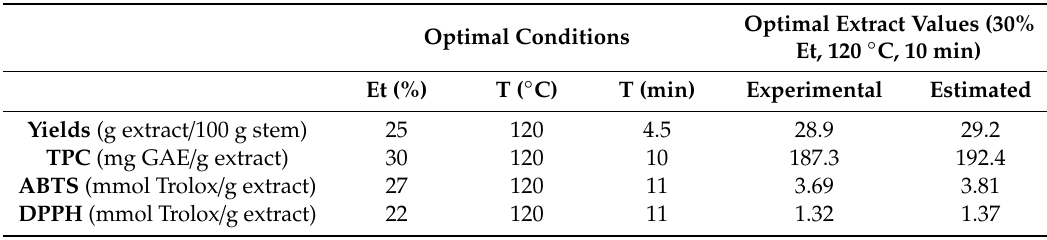
Table 4. Optimal extraction conditions, experimental and estimated values for response variables in the optimum